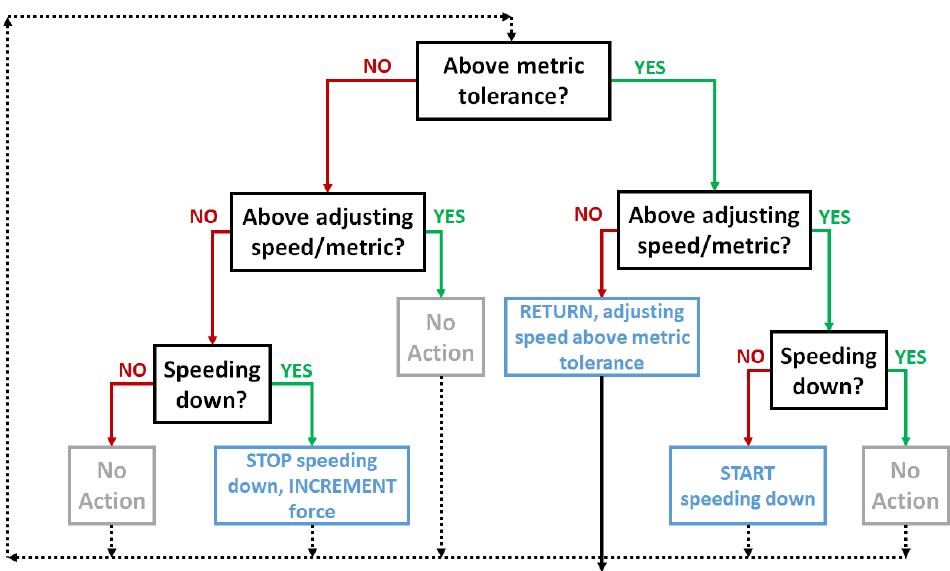
Figure 5. Bending control loop used by the algorithm to control the rotor speed and the bending moment